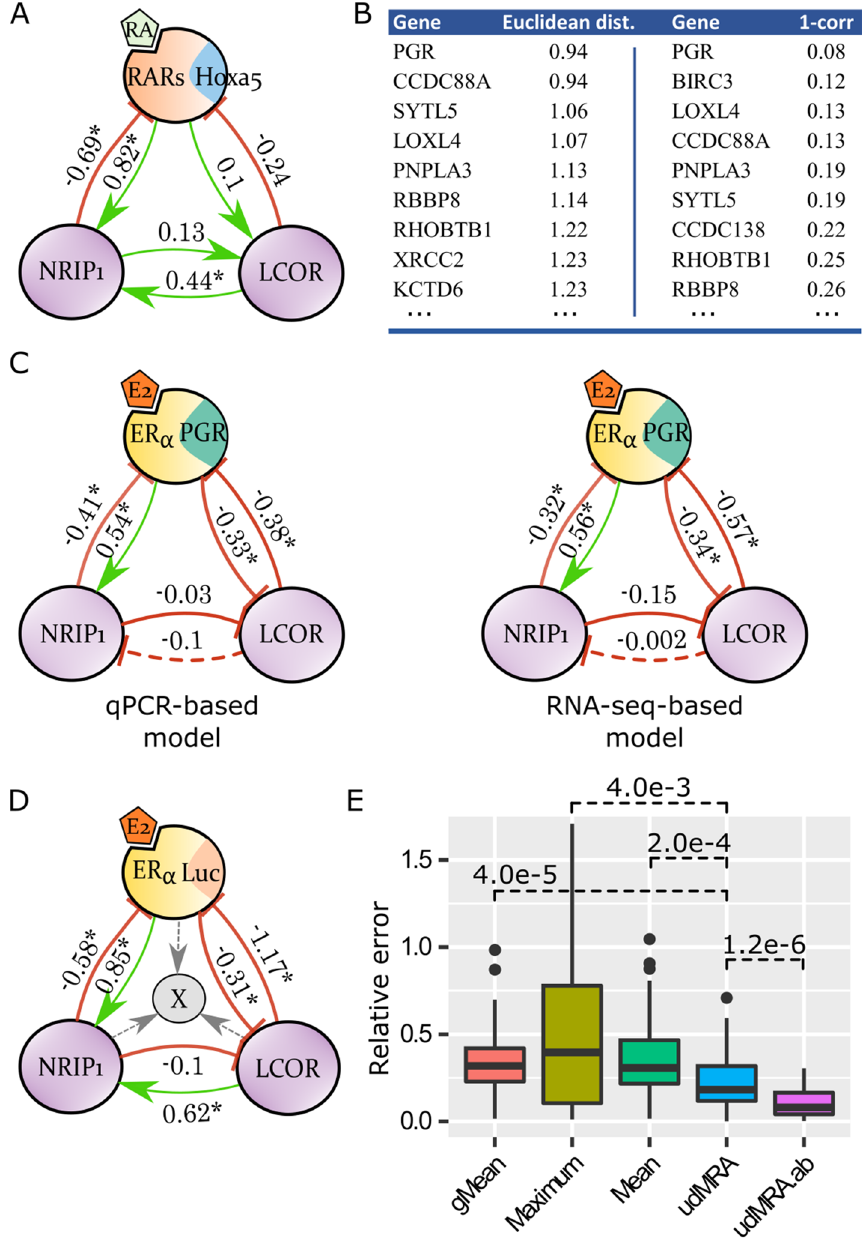
Figure 4. Application to RNA-seq data and genomic predictions. ( A ) RARs-NRIP1-LCoR network inferred from RNA-seq data. ( B ) Nine closest replacement genes for ERE-Luc in the ERα-NRIP1-LCoR network according to the Euclidean distance or 1-correlation. ( C ) ERα-NRIP1-LCoR networks with ERE-Luc replaced by PGR, trained from qPCR and RNA-seq data. ( D ) Principle of unidirectional MRA applications. ( E ) Accuracy of unidirectional MRA predictions (udMRA & udMRA.ab) under the E2 stimulation with double siNRIP1/siLCoR perturbation versus simple predictors (mean, geometric mean (gMean), and maximum of the two siRNAs). Wilcoxon test (n = 60). Figure created with Inkscape 0.92 (www. inksc ape. org) and R 3.6